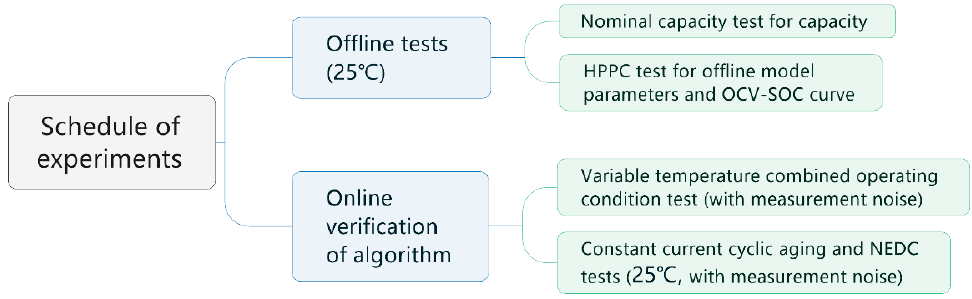
Figure 6. The schedule of experiments.